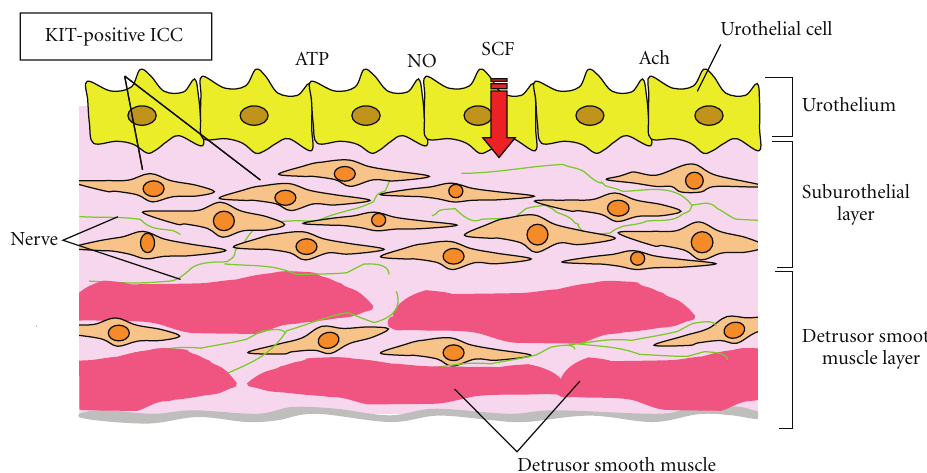
Figure 1: Distribution and morphology of Kit-positive suburothelial and detrusor ICCs and interaction with urothelium, nerves, and smooth